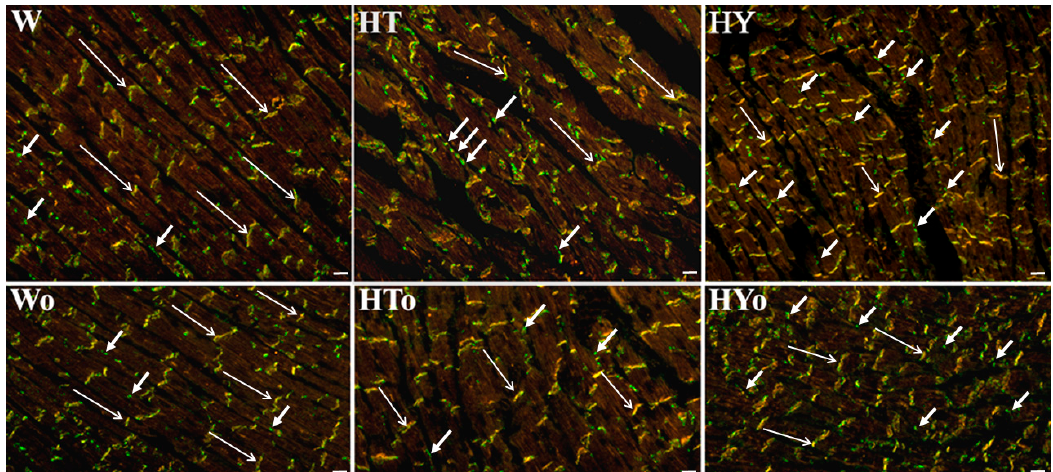
Figure 3. Topology of myocardial connexin-43 (Cx43, green) colocalized with N-cadherin (red) in the male normotensive rats with altered thyroid status with or without feeding with Omacor; W—Wistar Kyoto euthyroid control rats; o—fed with Omacor; HT—hyperthyroid rats; HY—hypothyroid rats. Note conventional immunofluorescence labeling of Cx43 and N-cadherin at the gap junctions (long arrows) and Cx43 on lateral surfaces of the cardiomyocytes (short arrows). Objective 40×, Scale bar 10 µm.